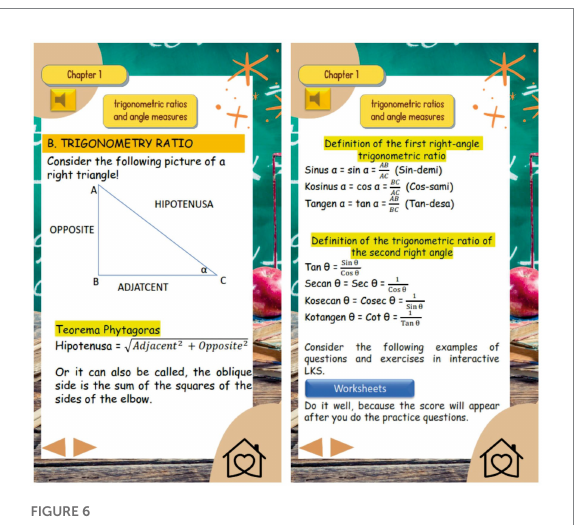
FIGURE 6 Worksheets and resource